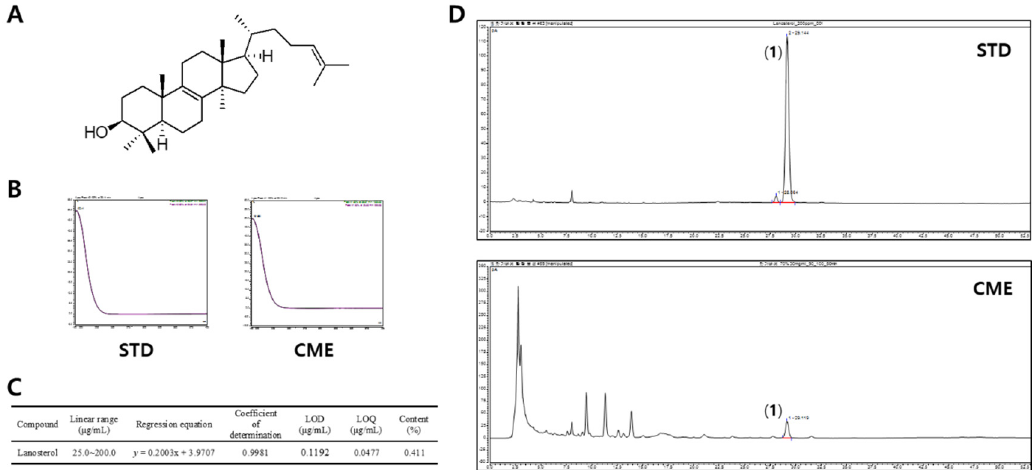
Figure 4. Structure of lanosterol ( 1 ) ( A ); UV spectra of the standard compound of lanosterol ( 1 ) and 70% ethanol extract ( B ); regression equations, LODs, and LOQs of lanosterol ( C ); and HPLC–CAD chromatograms ( D ).